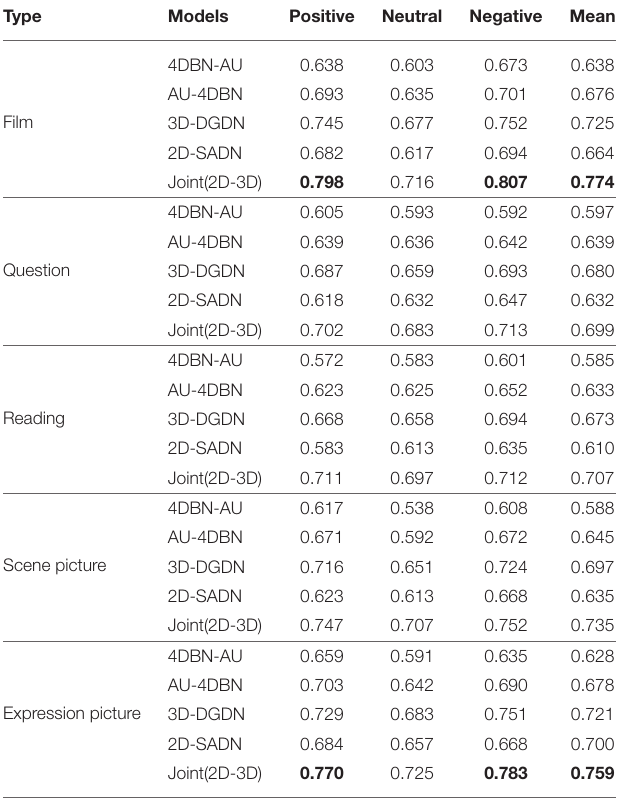
TABLE 3 | The accuracy of all models for three emotional valences of five stimuli.